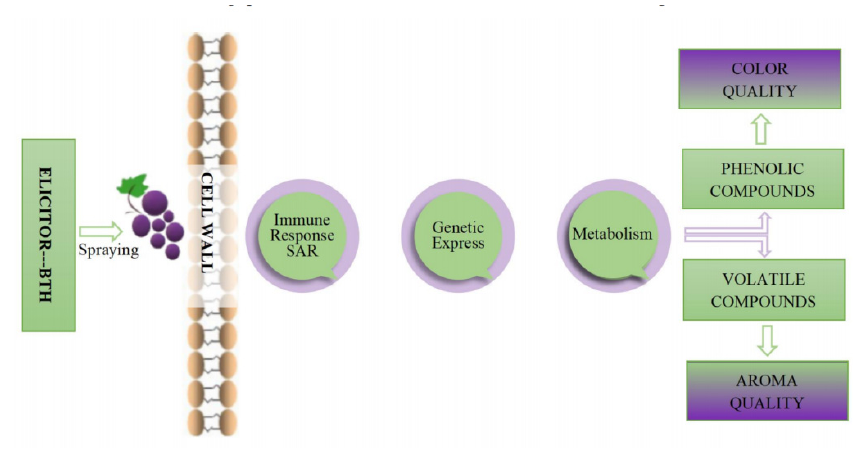
Figure 2. Impact of BTH spraying on the color and aroma of grapes.